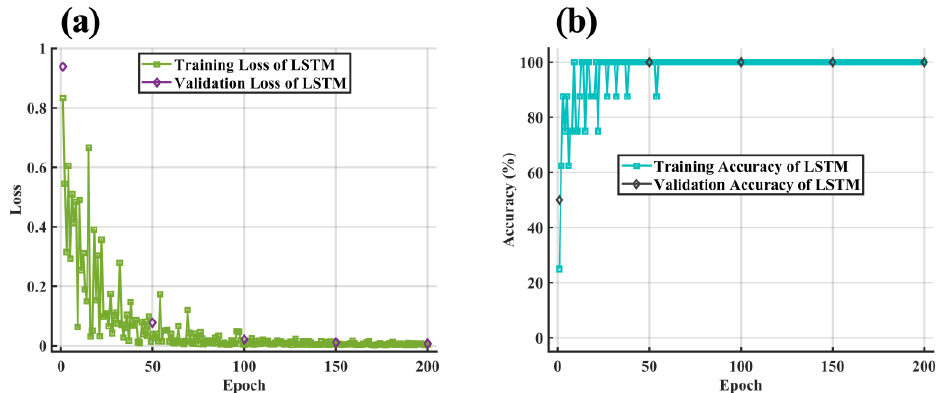
Figure 13. ( a ) The loss and ( b ) the accuracy curve of the LSTM training process.